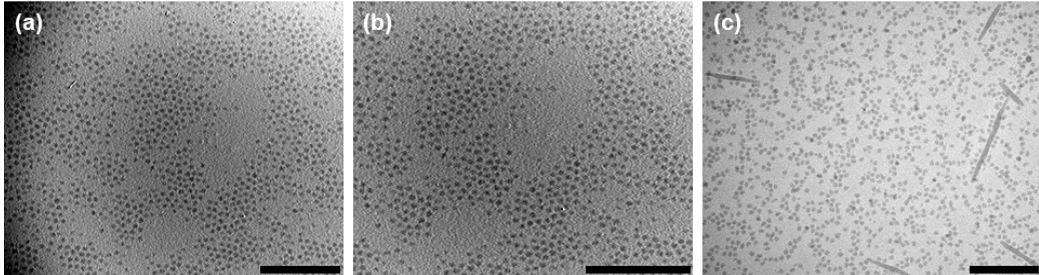
Figure 5. Bright field TEM images of the self-assembly of BCP 8a at different rates of addition of 2-propanol. ( a ) 50% vol. of 2-propanol in one-step. ( b ) 100% vol. of 2-propanol in one-step. ( c ) 100% vol. of 2-propanol at the rate of 1 drop/2 sec. Inside scale bars correspond to 500 nm. Importantly, attempts to create regular cylindrical micelles by adding 100% vol. of 2-propanol over THF solution (0.5 mg/mL) of 8a in two steps (i.e., firstly, a 50% vol. of 2-propanol was added